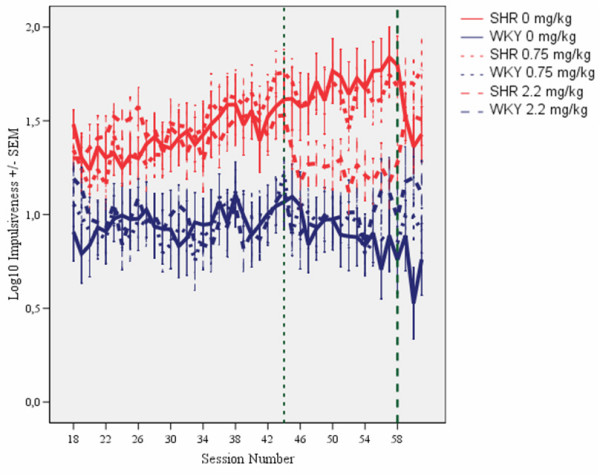
Effects of l-amphetamine on impulsiveness, responding within 0.67 s following the previous lever press, of SHR and WKY controls following log10 transformation. Means ± SEM. Sessions 31 through 44 served as baseline sessions. Treatment was given at sessions 45 through 58. Sessions 59 through 61 were used for studying post-treatment effects, except for the groups that received vehicle (saline, 0 mg/kg) during treatment sessions 45-58. These groups received 2.2 mg/kg l-amphetamine to check for typical responsiveness to the drug for SHR and WKY.